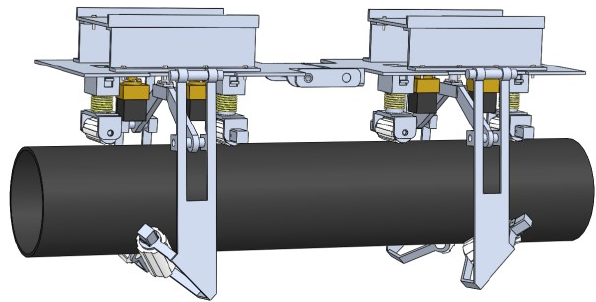
Figure 4. The three-dimensional model of the pipe-climbing robot.